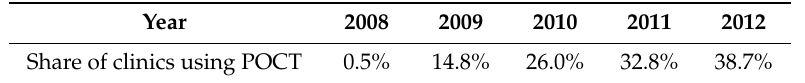
Table 3. Uptake of POCT of HbA1c among general practice (GP) clinics in the capital region.